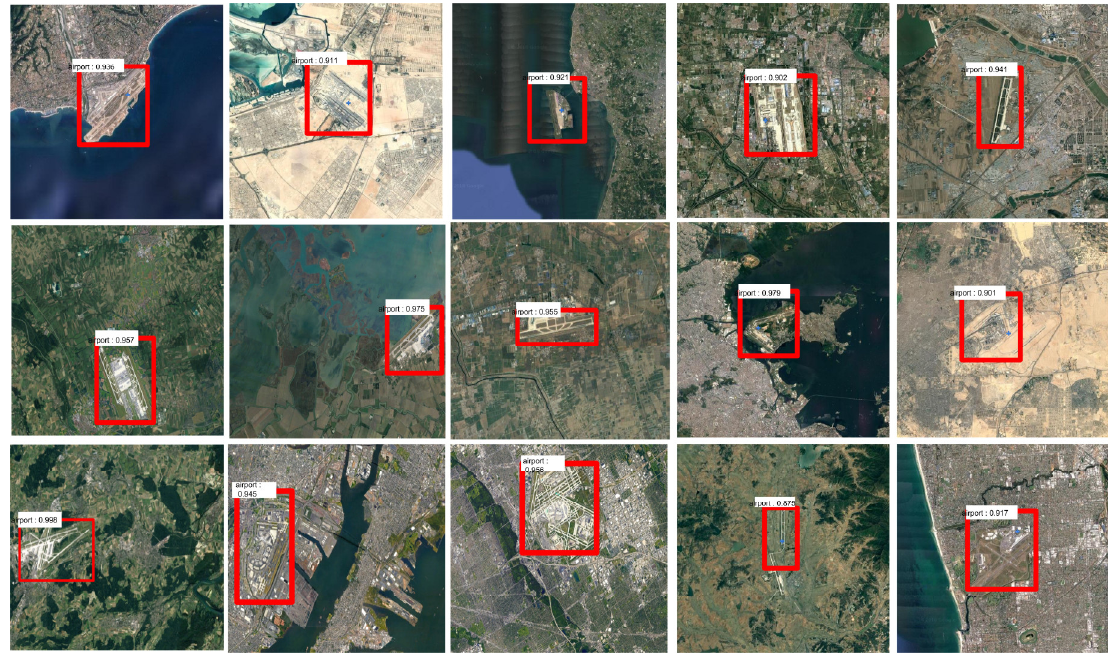
Figure 9. Various airport detection results.